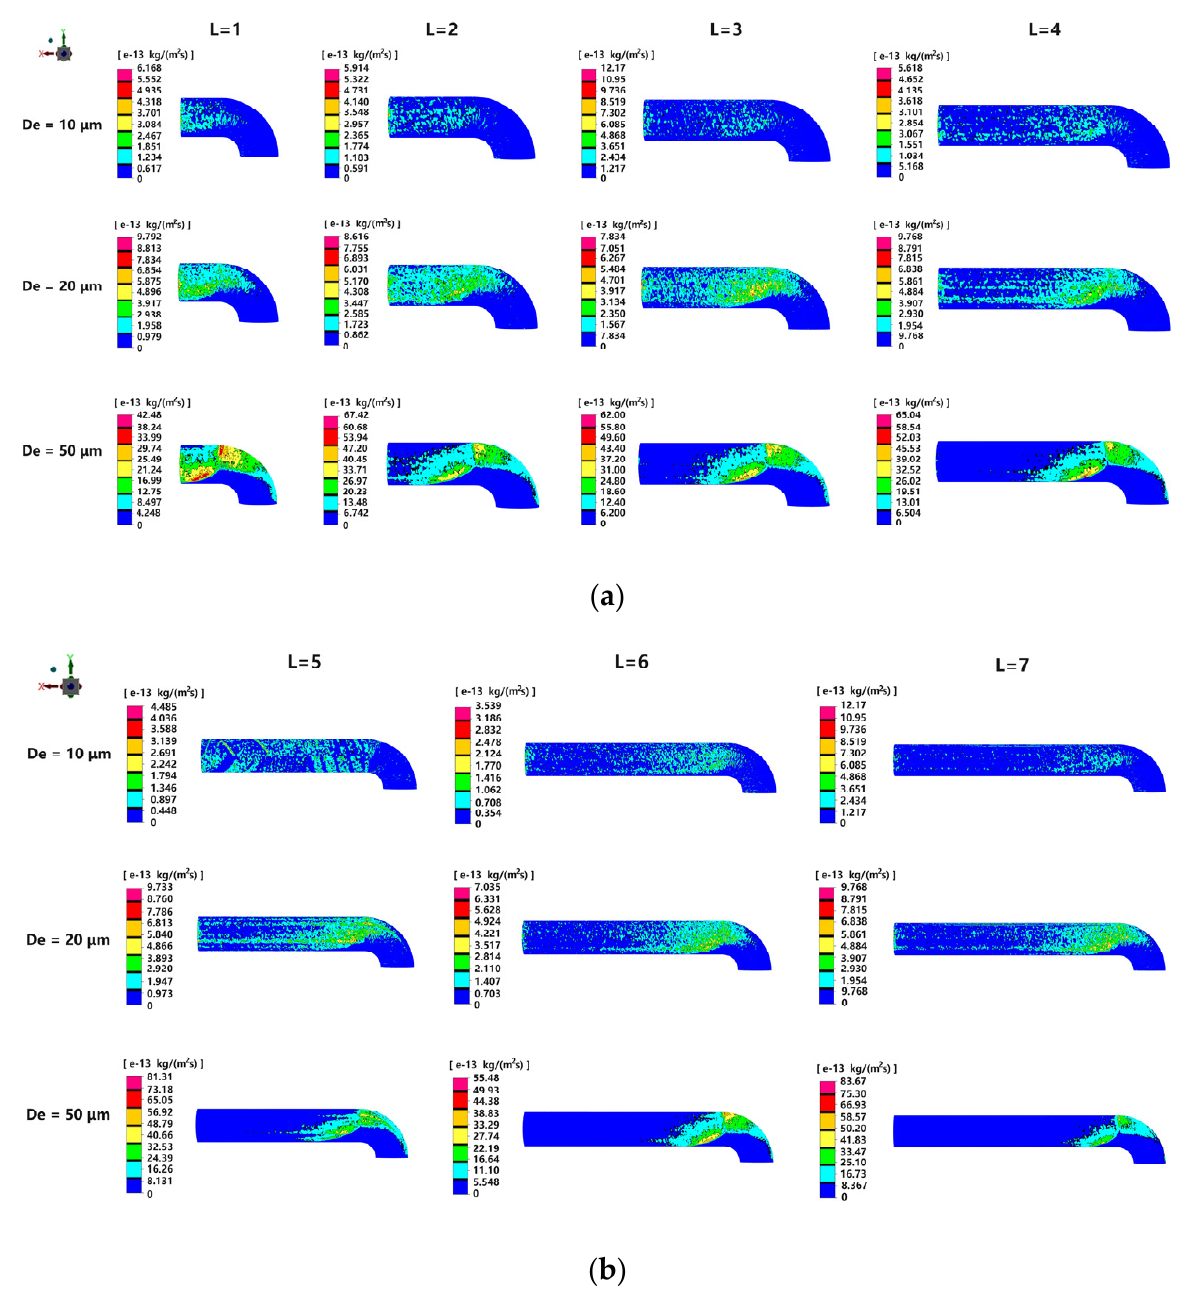
Figure 13. The erosion contours at Elbow-1 and Straight-2 with the different Straight-2 lengths and different average diameters: ( a ) The length of Straight-2 is from 1 m to 4 m; ( b ) the length of Straight-2 is from 5 m to 7 m.